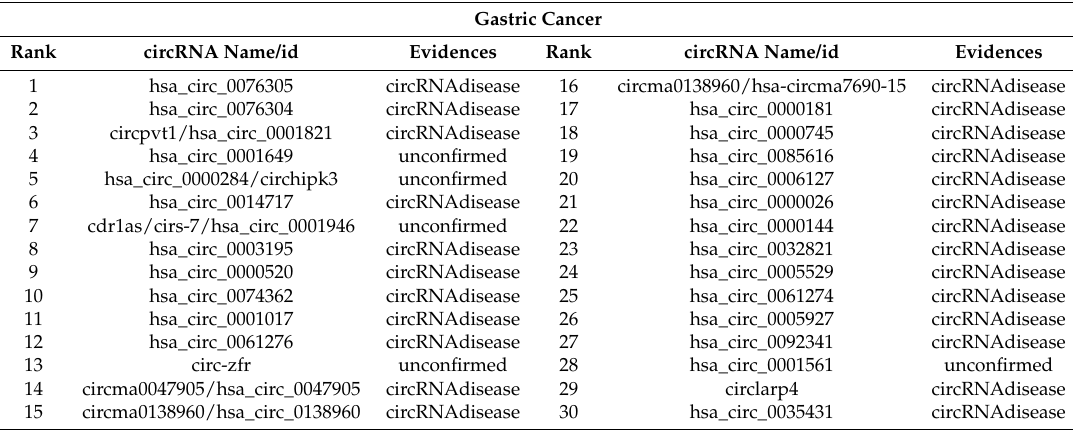
Table 4. The top 30 gastric cancer related candidates circRNAs.